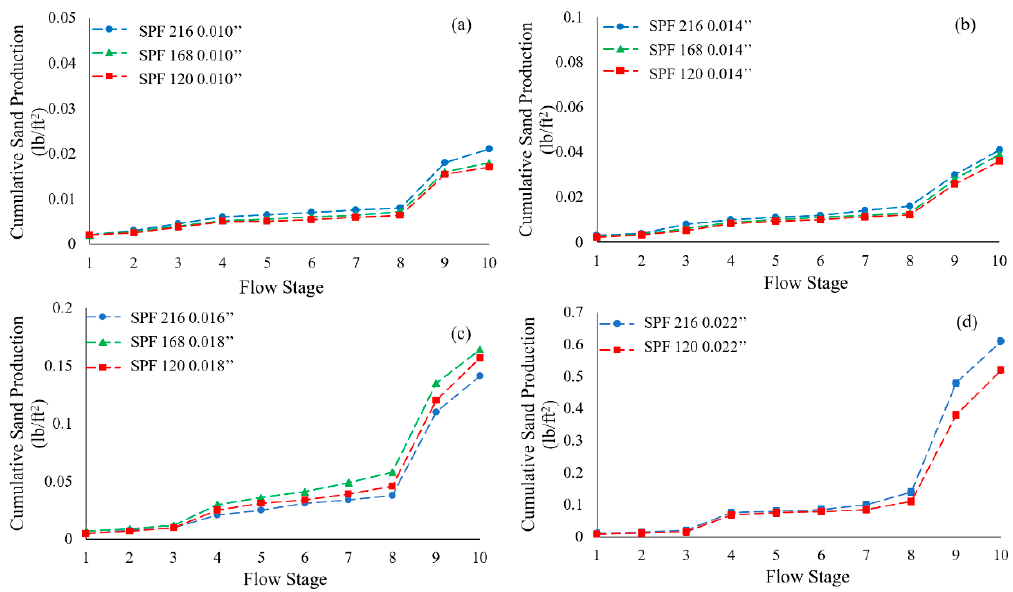
Figure 10. Produced sand results for DC ‐ III using slot apertures of ( a ) 0.010 ′′ , ( b ) 0.014 ′′ , ( c ) (0.016 ′′ ) 0.018 ′′ , and ( d ) 0.022 ′′ .